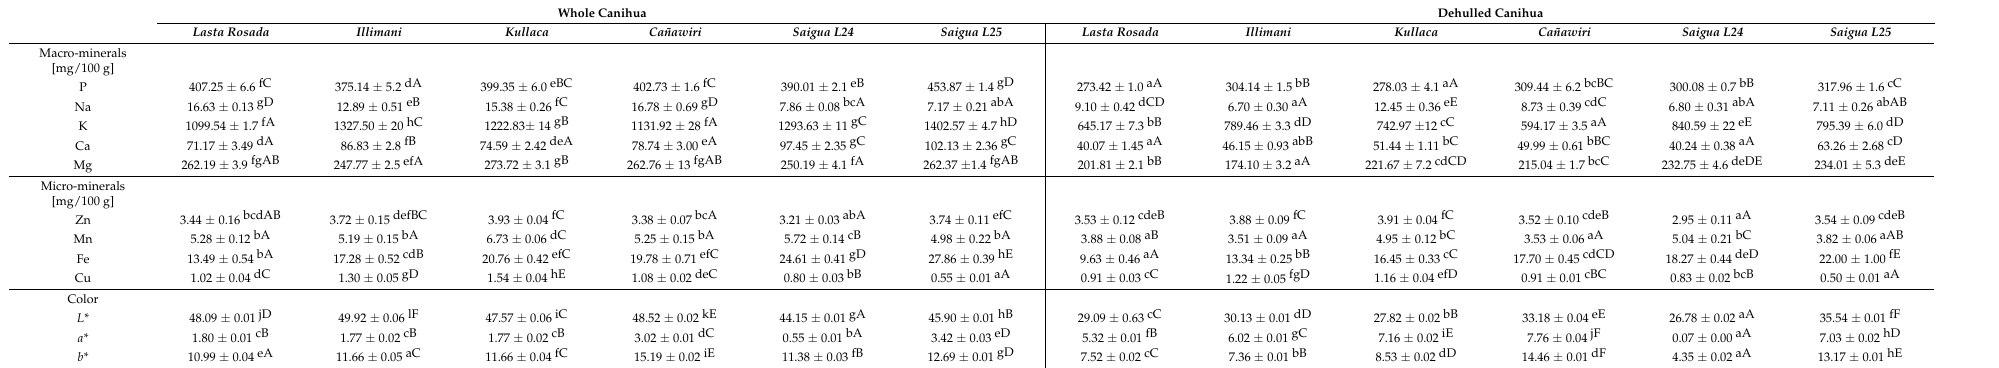
Table 3. Mineral composition of canihua ( Chenopodium pallidicaule ) cultivars. All values [mg/100 g] are presented in dry weight (dw), as mean ± standard deviation ( n = 3). For each compound, different superscript lowercase letters in rows indicate significant differences between canihua samples ( p < 0.05), and different uppercase letters indicate a significant difference between whole or dehulled grains ( p <